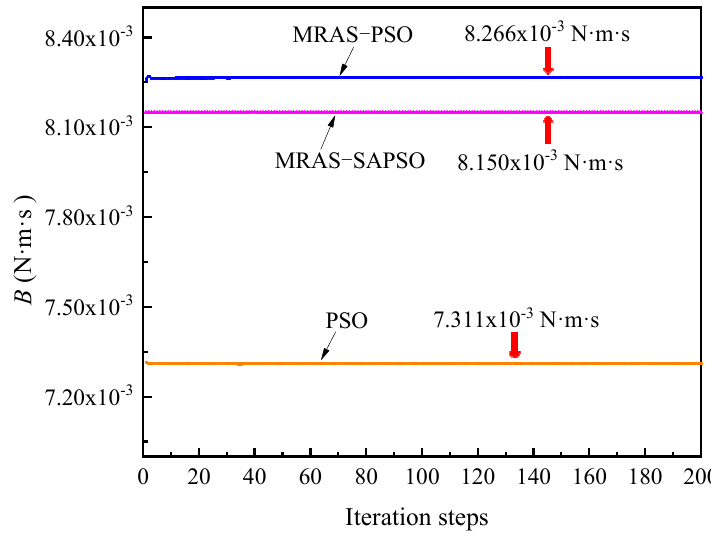
Figure 8. Damping coefficient identification curve.